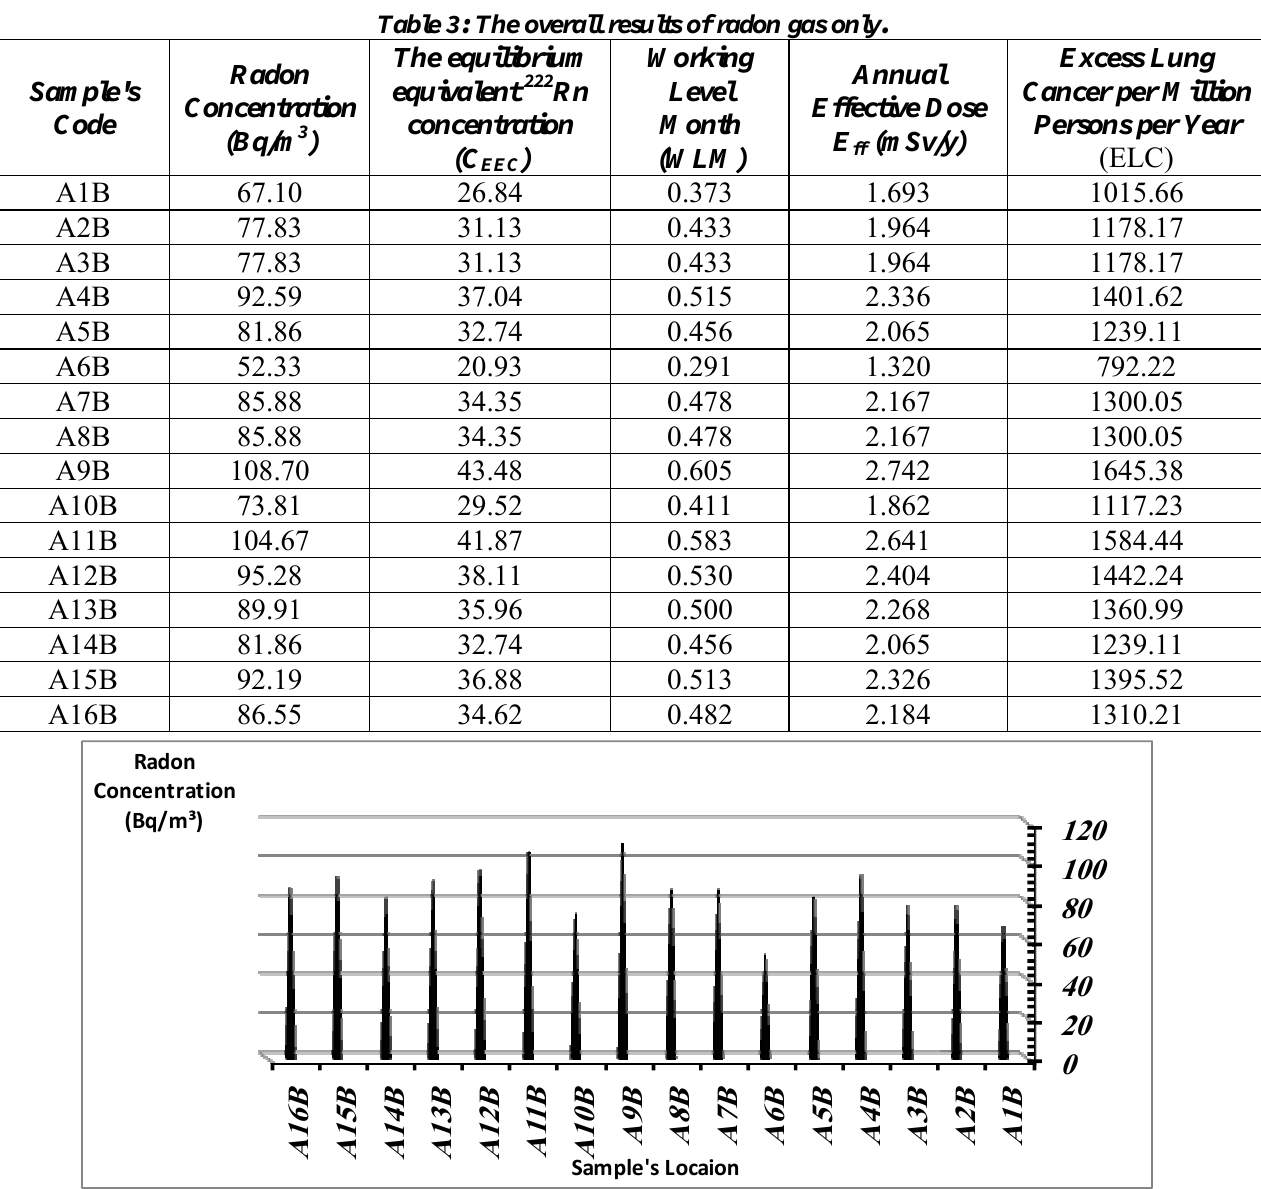
Fig. 2: Radon concentration at measured